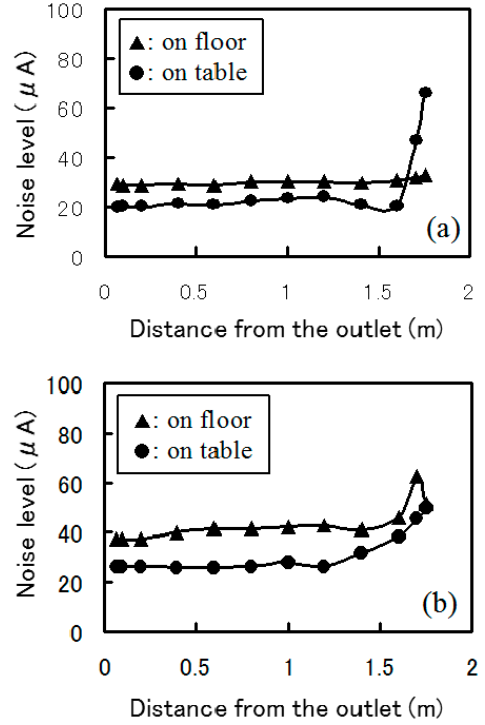
Figure 2. Dependences of the common-mode noise level on the distance from the outlet of the power cables: ( a ) personal computer (PC) power cable, ( b ) monitor power cables: ( a ) personal computer (PC) power cable, ( b ) monitor power cable.